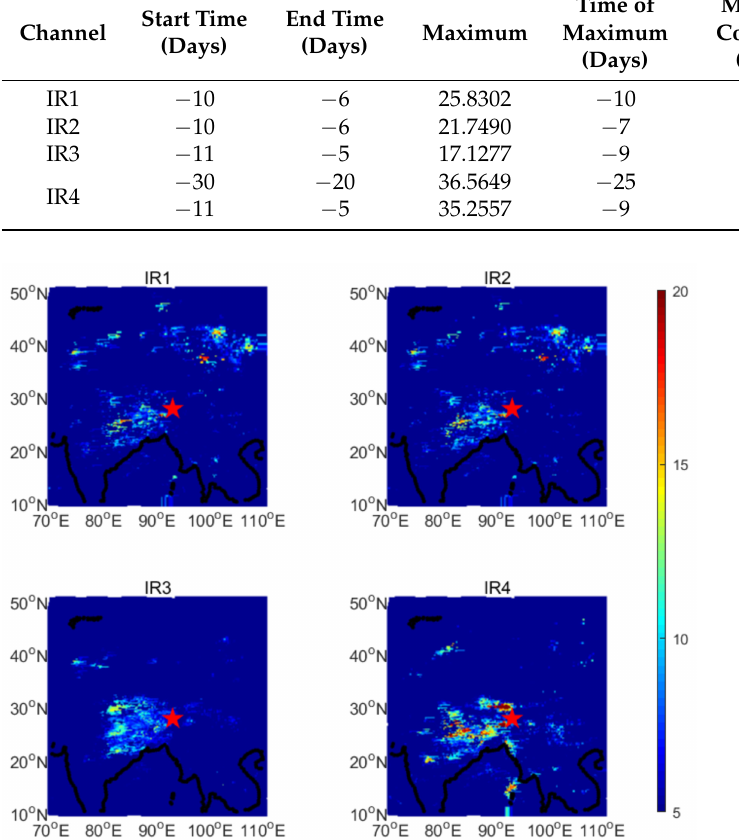
Figure 16. Power spectrum images on 7 July 2019.